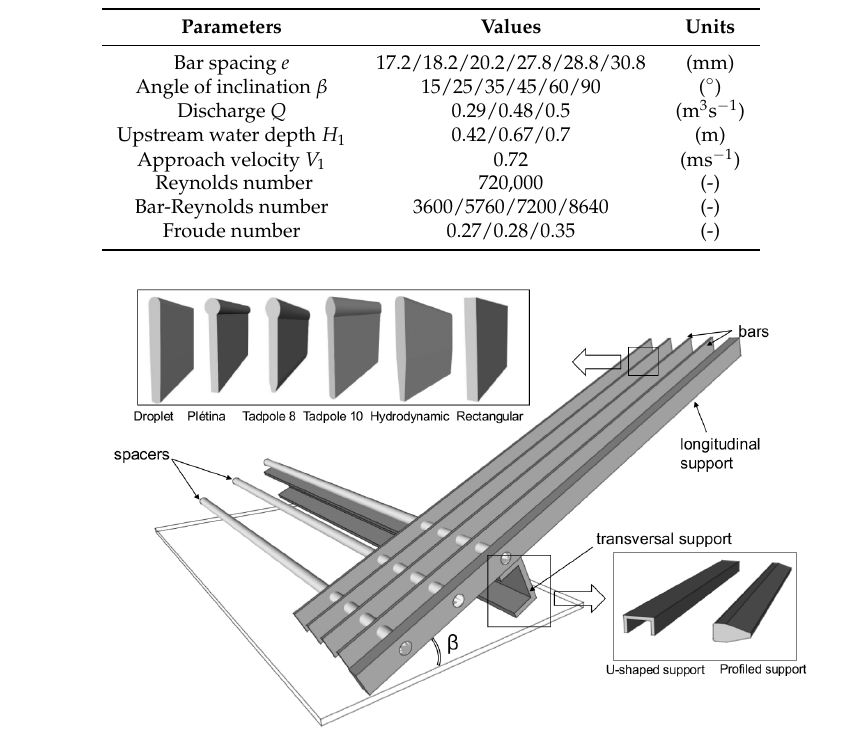
Figure 2. Trash rack components (bars, spacers, transversal supports, and longitudinal supports) and tested bar shapes.